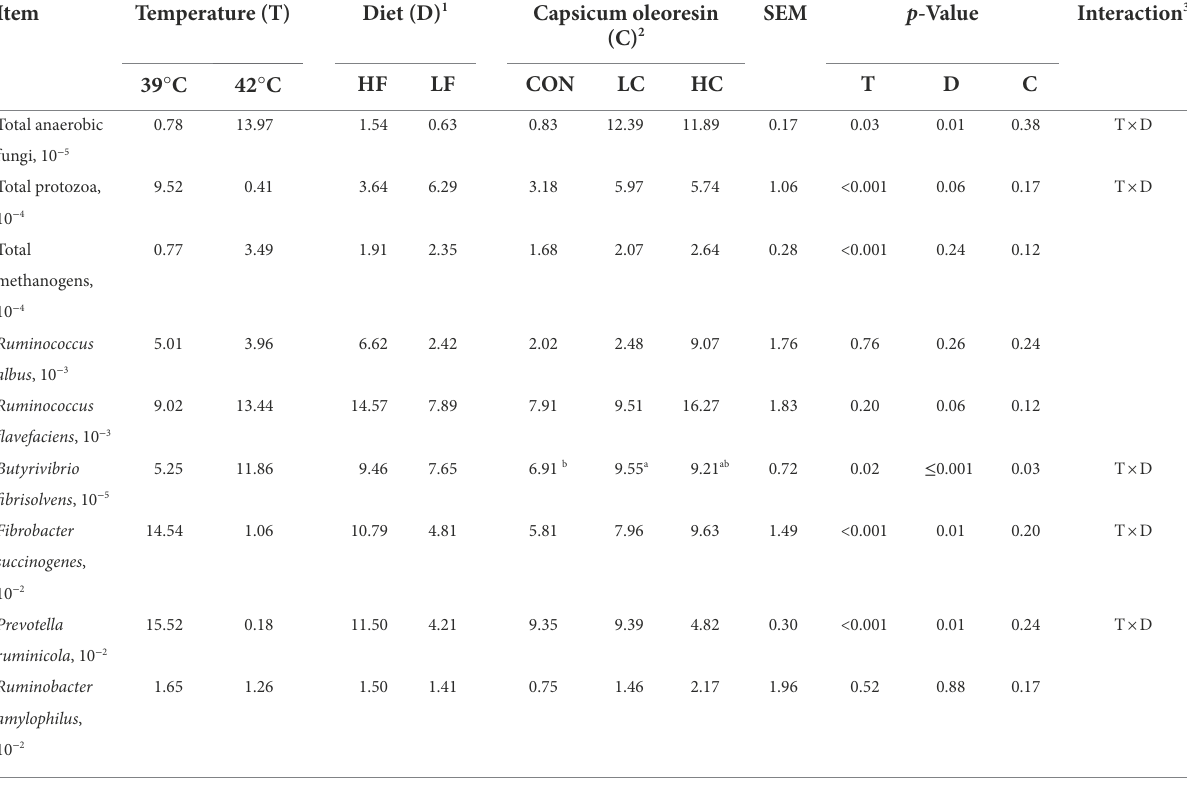
TABLE 4 Microbial relative abundance as affected by incubation temperature, dietary conditions, CAP supplementation, and their